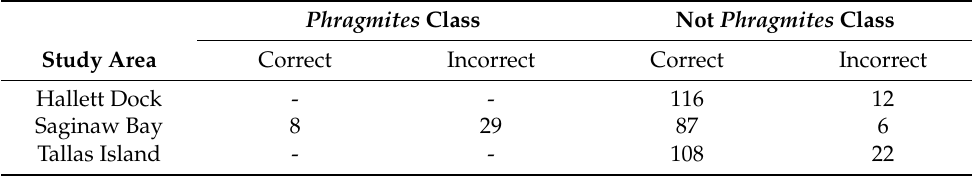
Figure 7. Mapping Phragmites using RGB UAS imagery with a satellite-derived CHM for ( A ) Hallett Dock, ( B ) Tallas Island, and ( C ) Saginaw Bay. DSMs were created by the Polar Geospatial Center from DigitalGlobe, Inc. imagery. Table 9. Validated assessment points from each study area for the classification using the RGB UAS imagery and a satellite-derived CHM. Points are split by class ( Phragmites , Not Phragmites ) and if they were correctly identified (Correct,